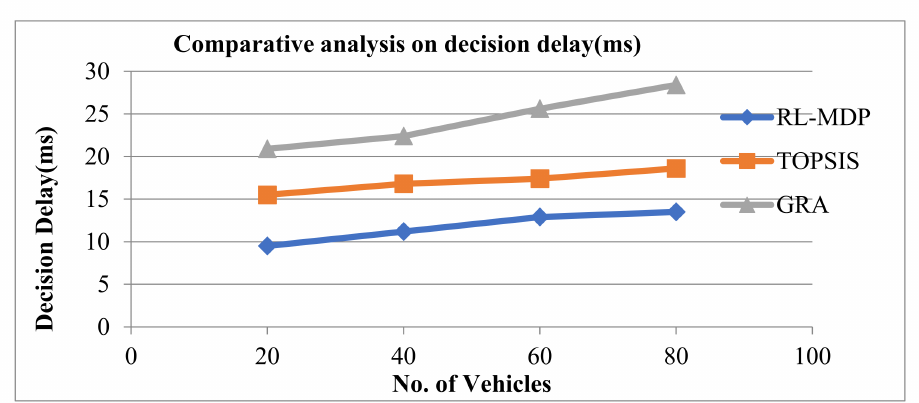
Figure 9. Comparative analysis of decision delay.